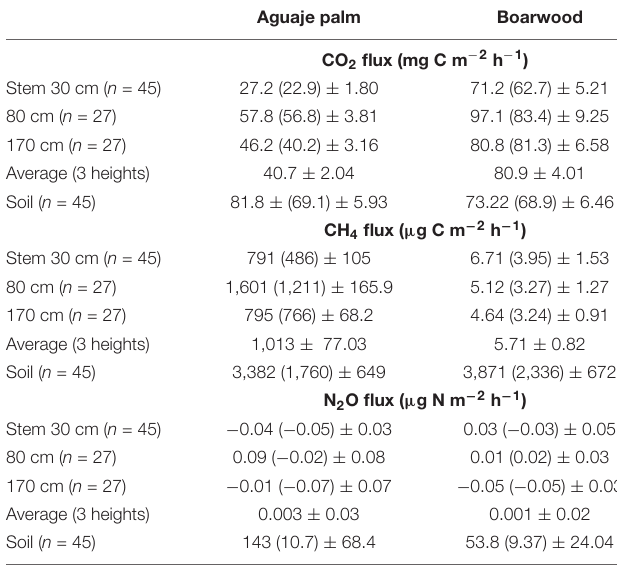
TABLE 1 | Average, median (in parentheses) ± SE stem CO 2 , CH 4 , and N 2 O fluxes from different stem heights and the soil in the Quistococha peat swamp forest.